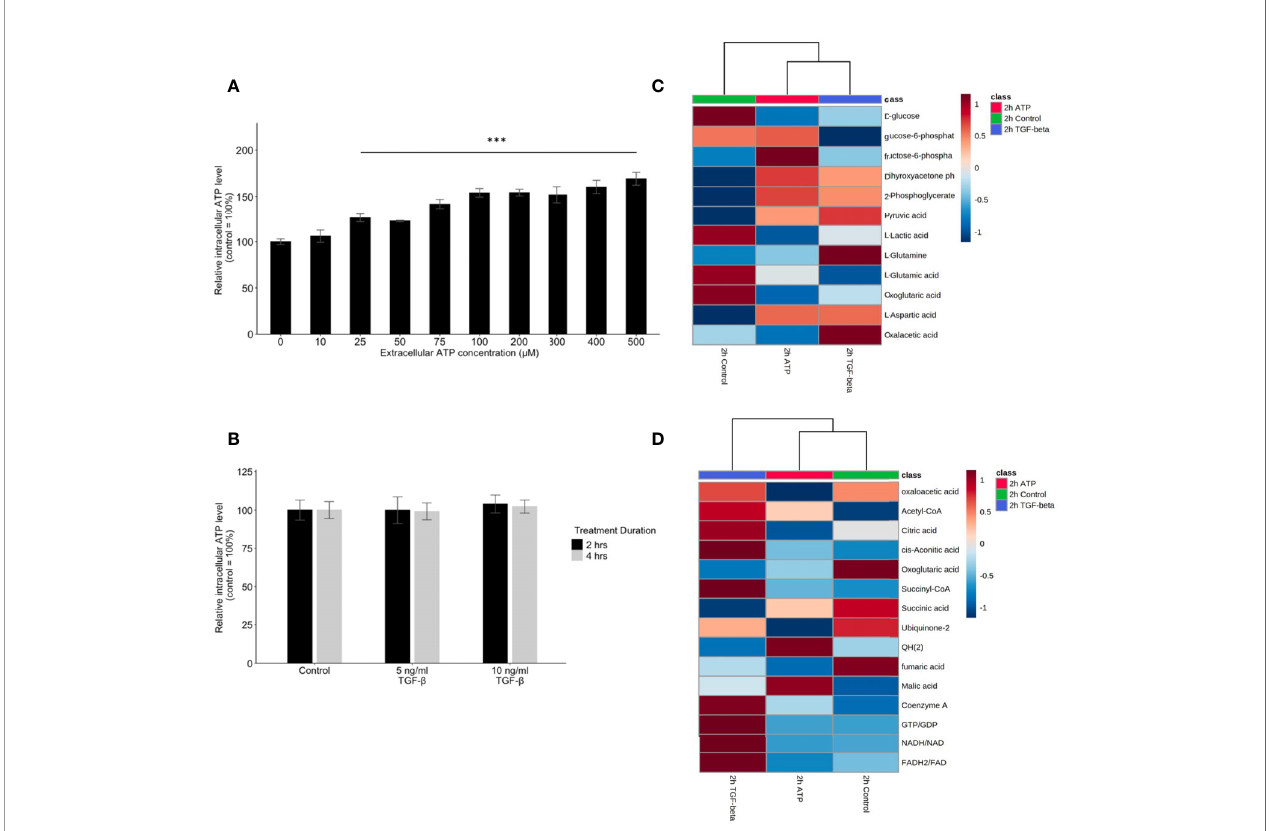
FIGURE 6 | Mechanism study II: similarity and difference between eATP and TGF- b in intracellular ATP and in ATP synthesis-related metabolites. A549 cells were treated with either various concentrations of ATP or TGF- b . 24 hours after the treatment, cells were lysed and measured for their intracellular ATP concentrations. A549 cells were also treated by ATP and TGF-b for 2 hours and then their speci fi c metabolites analyzed. ***P <.001. (A, B) Intracellular ATP levels of cells treated by various concentrations of ATP (A) and TGF- b (B) . (C, D) Heatmaps of concentrations of metabolites involved in glycolysis (C) or TCA cycle (D) in cells treated with ATP or TGF- b for 2 hours compared with the untreated